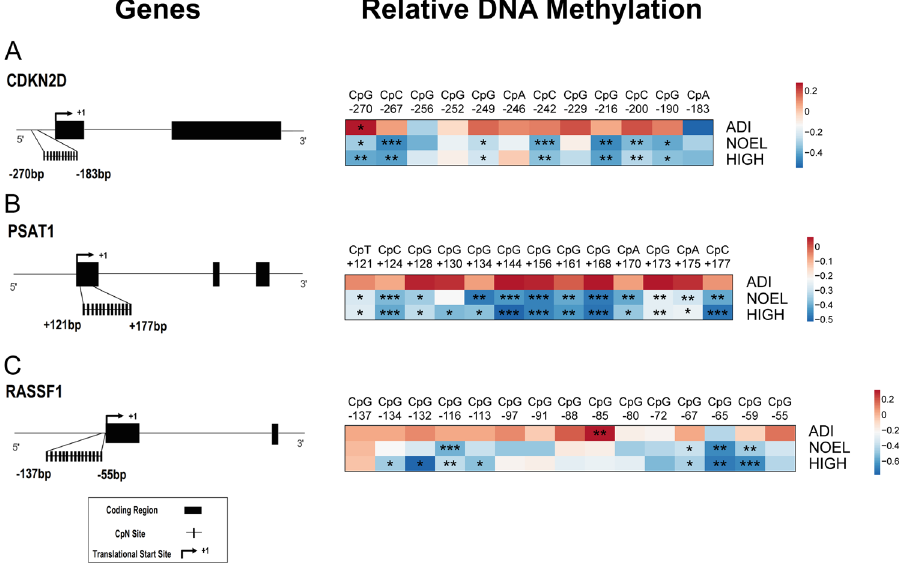
Figure 3. Heat maps showing gene-specific DNA hypomethylation at CpN sites of NOEL and HIGH dose groups of F 0 liver. Each column of the heat maps shown represents a CpN site analysed with its position with respect to the translational start site (indicated by + 1), while each row represents the log 2 methylation relative to control (0.05, 10, and 1000 μ g/kg body weight/day represented by ADI, NOEL, and HIGH, respectively). * , ** , and *** indicate statistical significance compared to the control group at p < 0.05, p < 0.01, and p < 0.001 respectively (n = 4–6 per group). ( A ) Gene diagram of CDKN2D , indicating the CpN sites analysed in the putative promoter region. ( B ) Gene diagram of PSAT1 indicating the CpN sites analysed in the coding region of the first exon. ( C ) Gene diagram of RASSF1 indicating the CpN sites analysed in the first